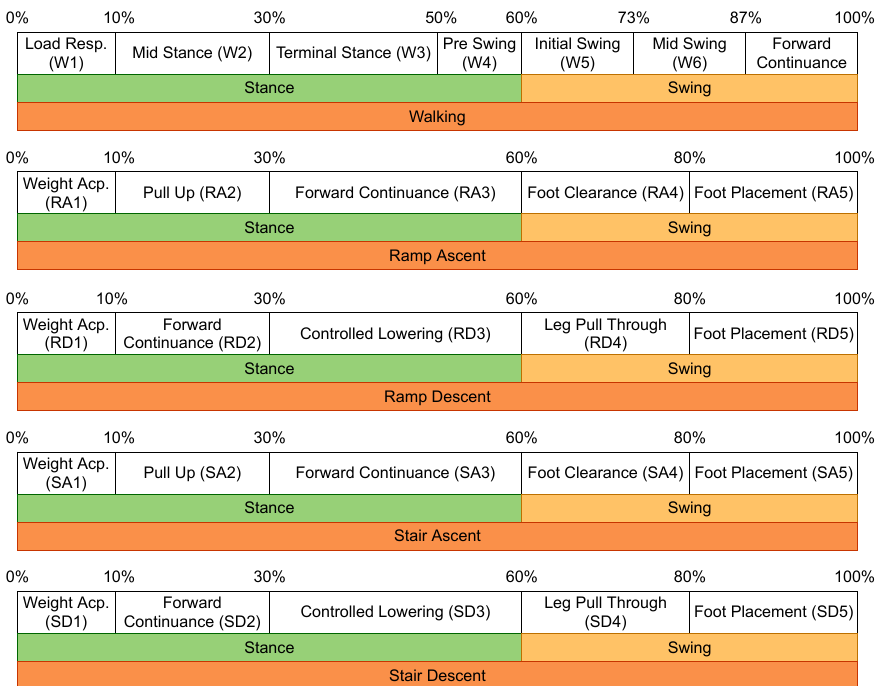
Figure 1. Locomotion modes and corresponding gait